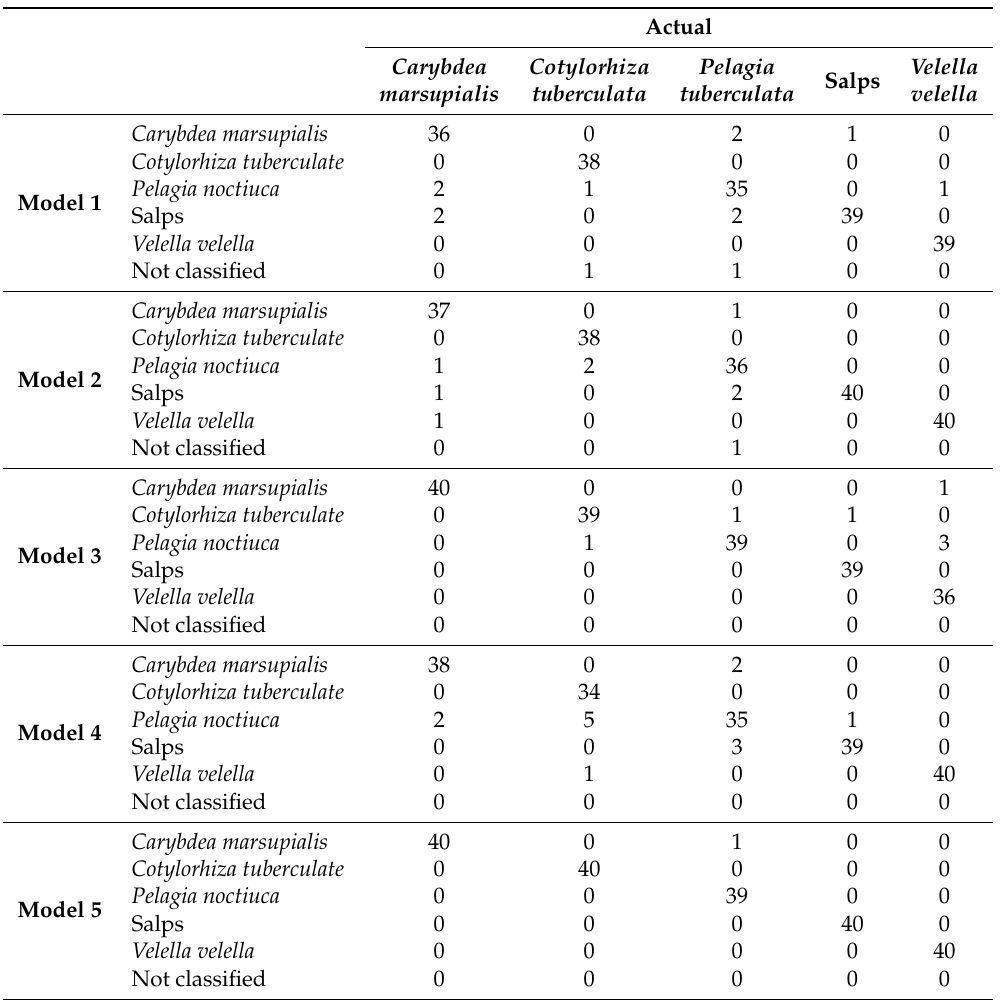
Table 3. Confusion matrices for